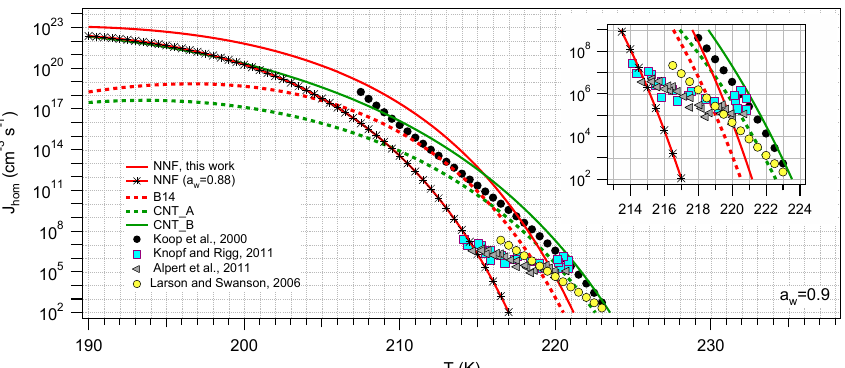
Figure 5. Homogeneous ice nucleation rate calculated using Eq. (16) (labeled “CNT”) and Eq. (11) (labeled “NNF”). For CNT_A (cid:49)G act was defined as in Zobrist et al. (2007), and for CNT_B it was calculated using Eq. (14); in both cases the empirical expression for σ iw from Barahona (2014) was used. For the model of Koop et al. (2000), a w,eq was defined as in Koop and Zobrist (2009). Also presented are experimental results and empirical formulations obtained from the